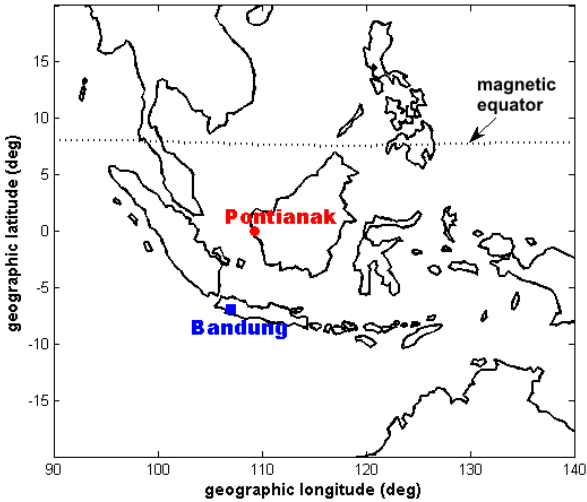
Fig. 1. The observation geography for studying latitudinal variation of ionospheric irregularities over the Indonesian sector. Figure 1. Observation geometry for studying latitudinal variation of ionopsheric irregularities 3 over Indonesian sector. 4